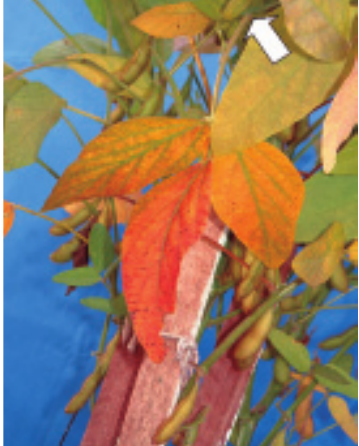
Figura 3. Detalhe de folha de soja com deficiência de P. Nota-se o sintoma de colapso do pecíolo